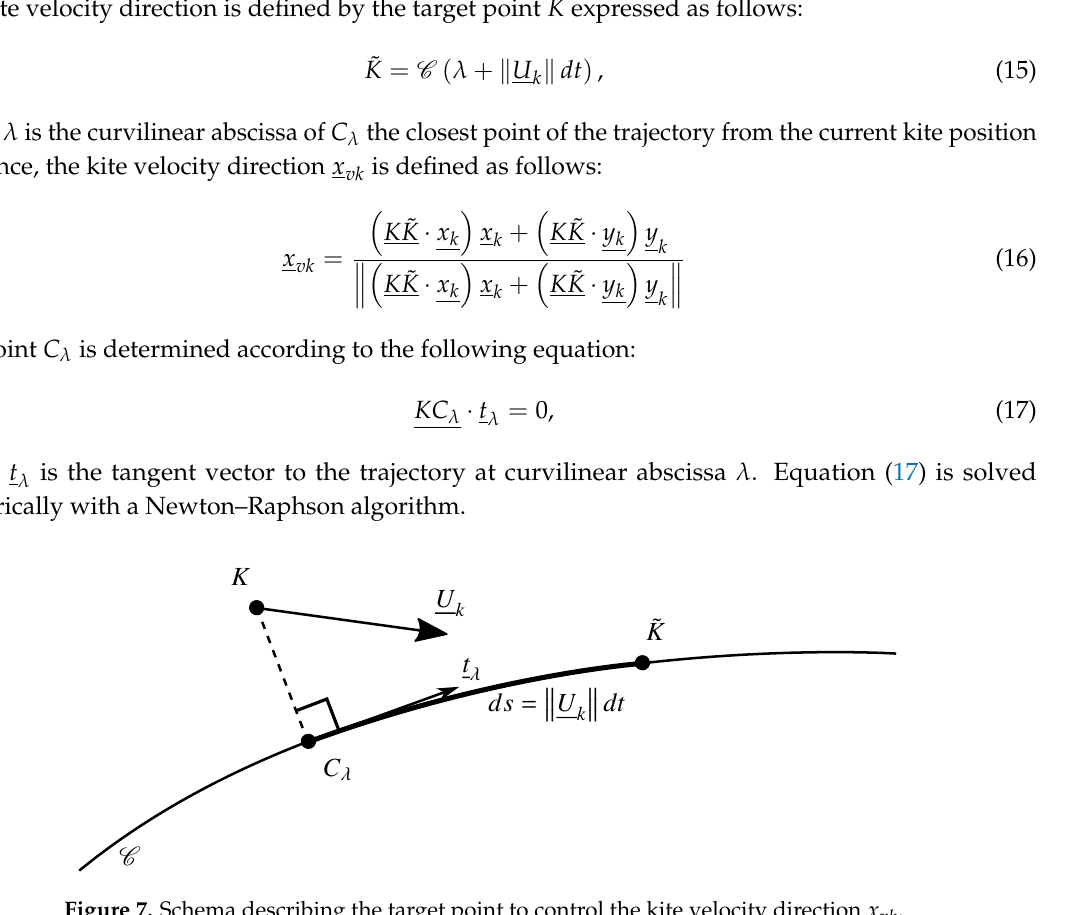
Figure 7. Schema describing the target point to control the kite velocity direction x vk